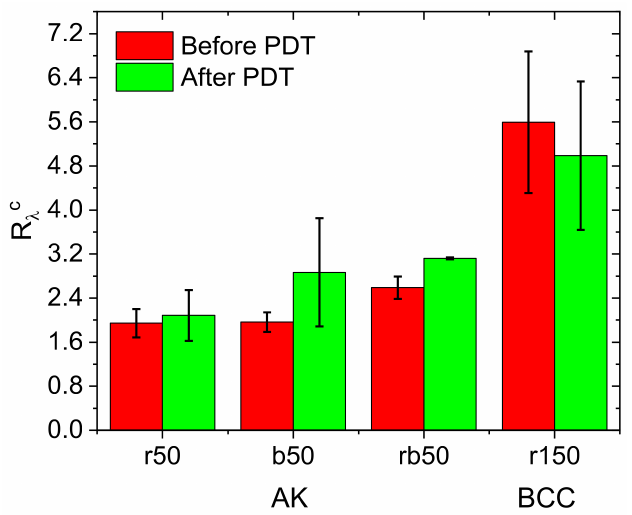
Figure 10. Fluorescence signal ratio prior to and after the PDT procedures obtained in the treatment of actinic keratosis (AK) with topical PS administration and basal cell carcinoma (BCC) with intravenous PS injection. The PDT regimes’ abbreviations below the bars show the therapeutic wavelength (‘r’ = 660 nm, ‘b’ = 405 nm, ‘rb’ = 660 nm + 405 nm) and dose in